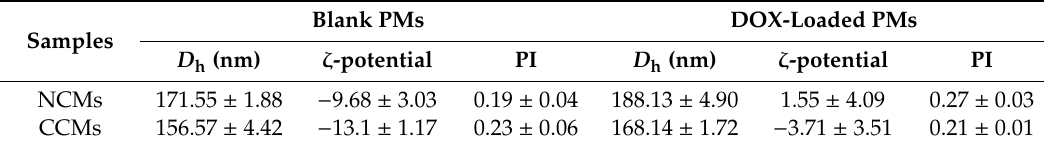
Table 2. Particle size and surface charges of blank and DOX-loaded polymeric micelles (PMs) *.